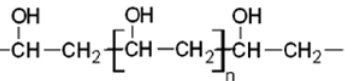
Figure 1: Chemical formula of polyvinyl